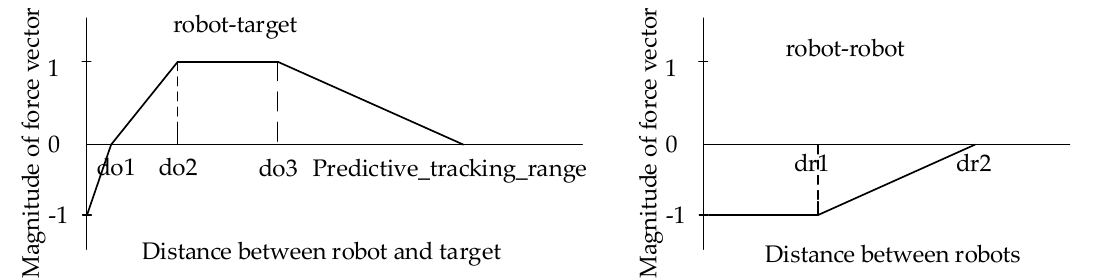
Figure 1. Magnitude of the force vectors from robot to target and robot to